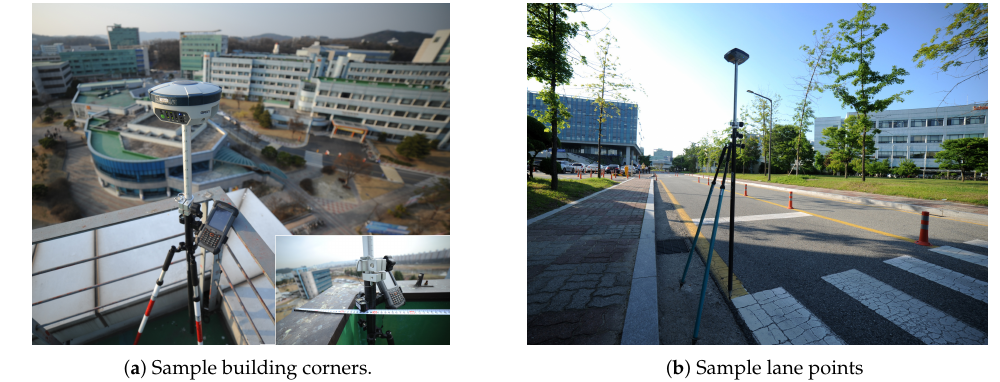
Figure 17. Accuracy analysis on sample points using VRS-GPS. ( a ) Four corners of the building rooftop are measured with building walls compensation. ( b ) Sample points on road marks are